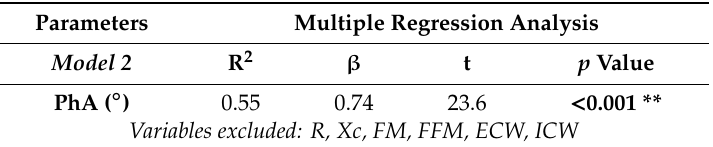
Table 6. Multiple regression analysis models (stepwise method) with the 25(OH)D levels as dependent variable to estimate the predictive value of: BMI and body composition parameters.